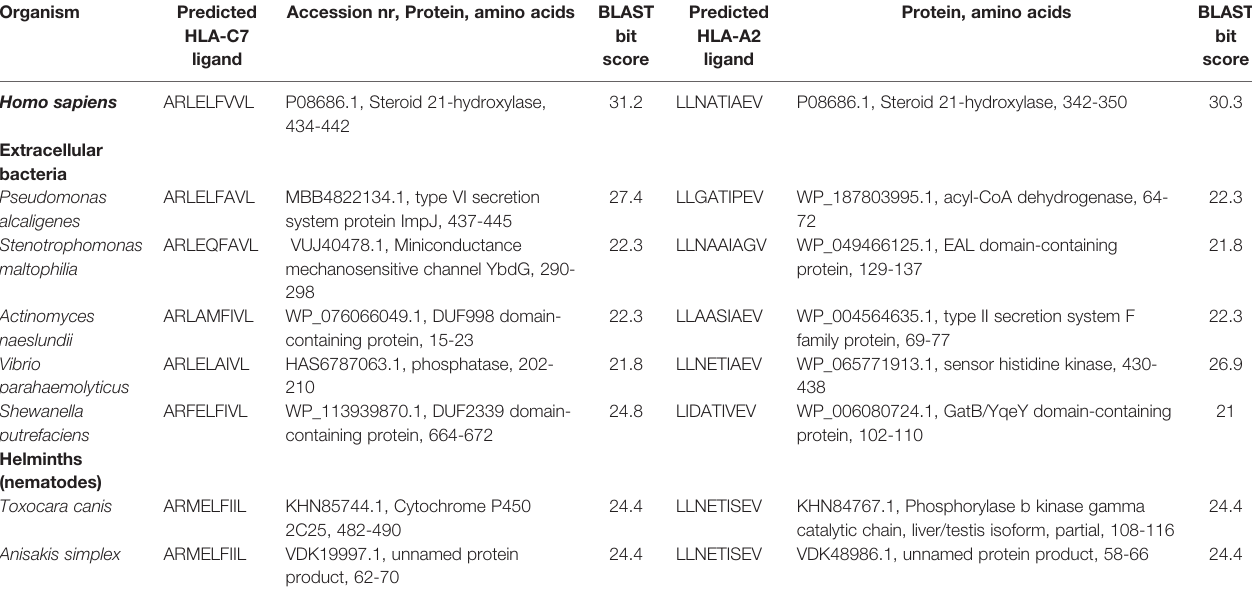
TABLE 2 | Peptides derived from extracellular bacteria and helminths reported to colonize humans with closest sequence homology to the CD8+ T cell restricted epitopes of 21OH.